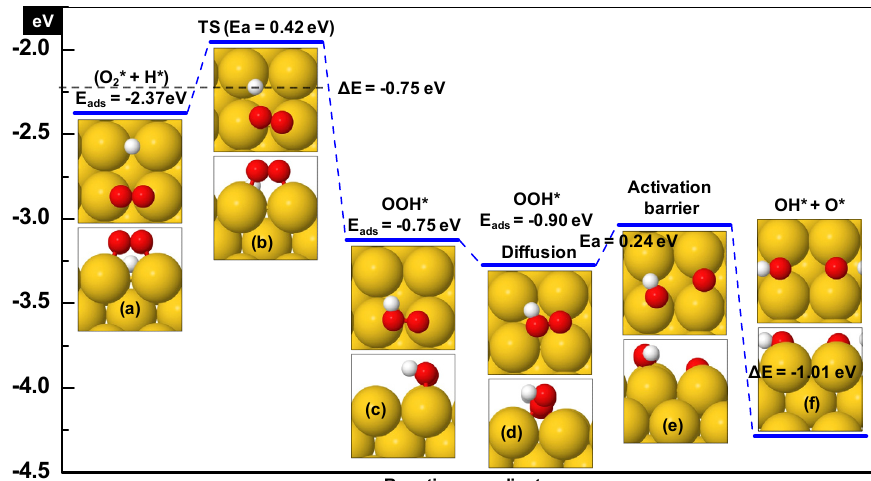
Figure 5. Potential energy diagram for hydroperoxy formation and decomposition on the Au(100) surface. The horizontal dashed line shows the desorption level of O corresponds to gas phase O , atomic hydrogen and the clean 2